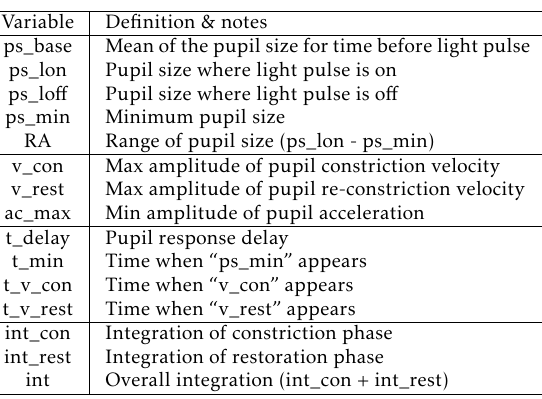
Table 2. Definitions of PLR